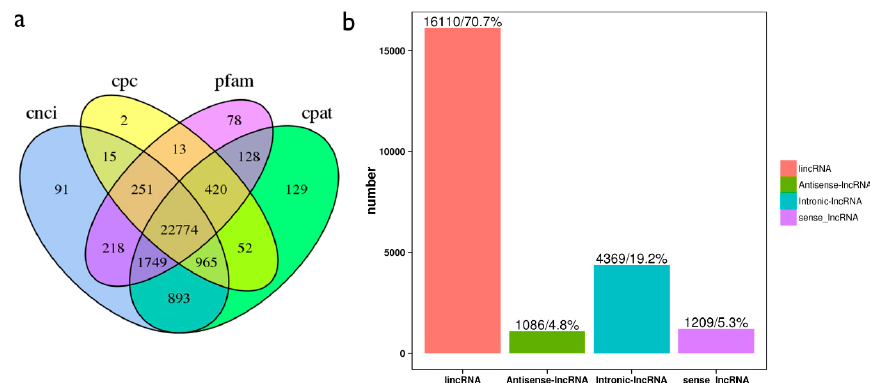
Figure 2. ( a ) Coding potential analysis of Venn diagram. Four tools (CNCI, CPC, CPAT and Pfam-scan) were selected to analyze the coding potential of lncRNAs. The data shared by the four tools were designated as candidates for subsequent analyses. ( b ) The identified lncRNAs were divided into four types, including intergenic lncRNA, antisense lncRNA, sense lncRNA and intronic lncRNA, and the number and proportion of each type of lncRNAs were also calculated.